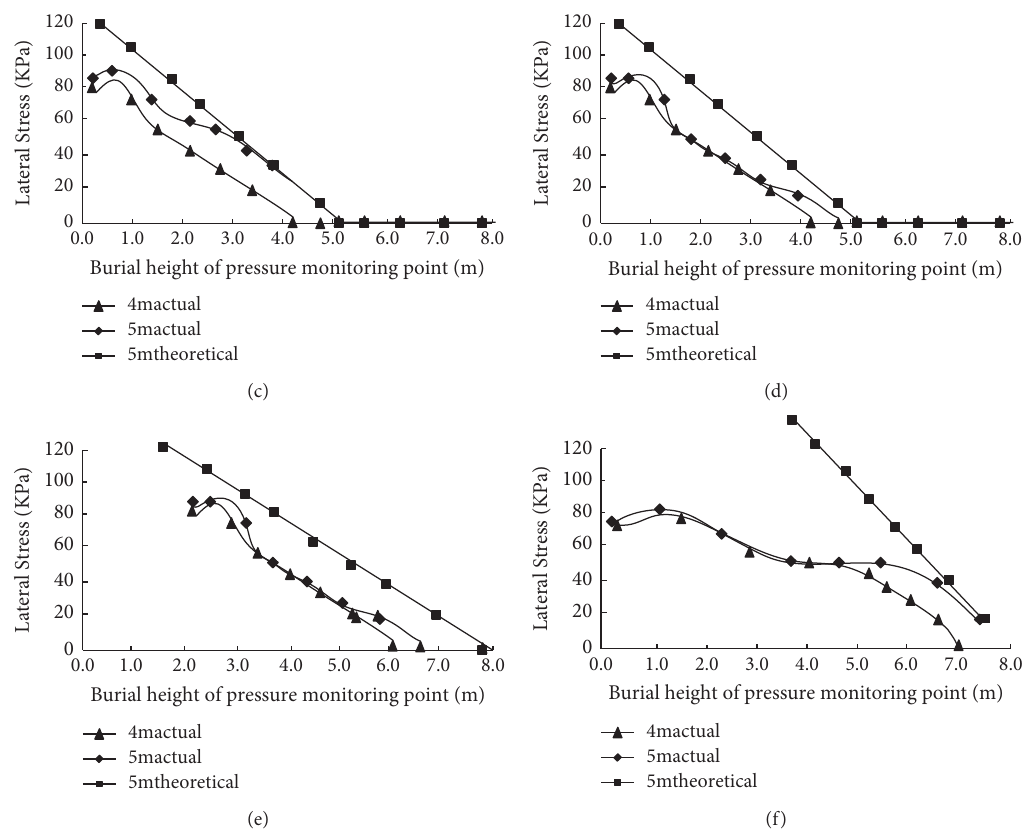
Figure 9: Measured lateral stress loaded on the steel plate with different concrete heights. (a) Lateral stress when pouring height is 5m. (b) Lateral stress when pouring height is 5.5 m. (c) Lateral stress when pouring height is 6m. (d) Lateral stress when pouring height is 6.5m. (e) Lateral stress when pouring height is 7.5m. (f) Lateral stress when pouring height is